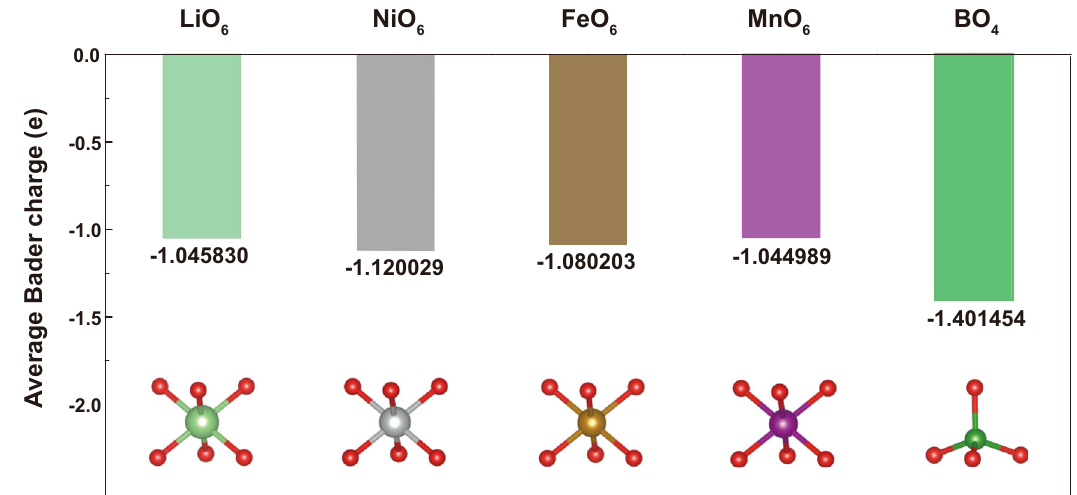
Fig. 1 Bader charge analysis. Average Bader charge of the O atoms in MO 6 octahedron (M = Ni/Fe/Mn/Li) and in BO